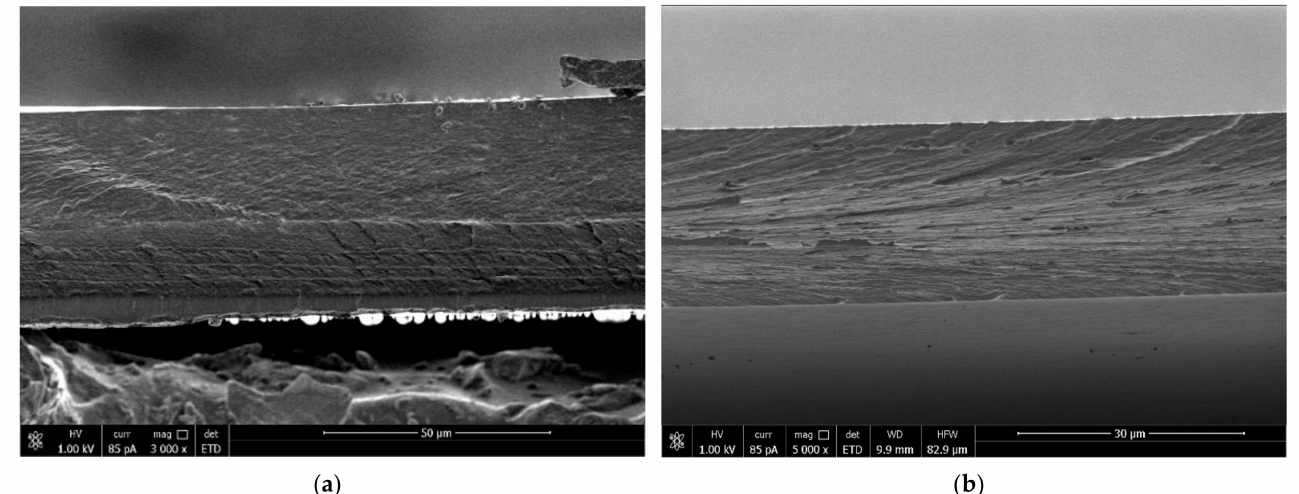
Figure 4. SEM images of cross sections of CS s –PEC SEC –SEC ( a ) and CS s –PEC HA –HA ( b